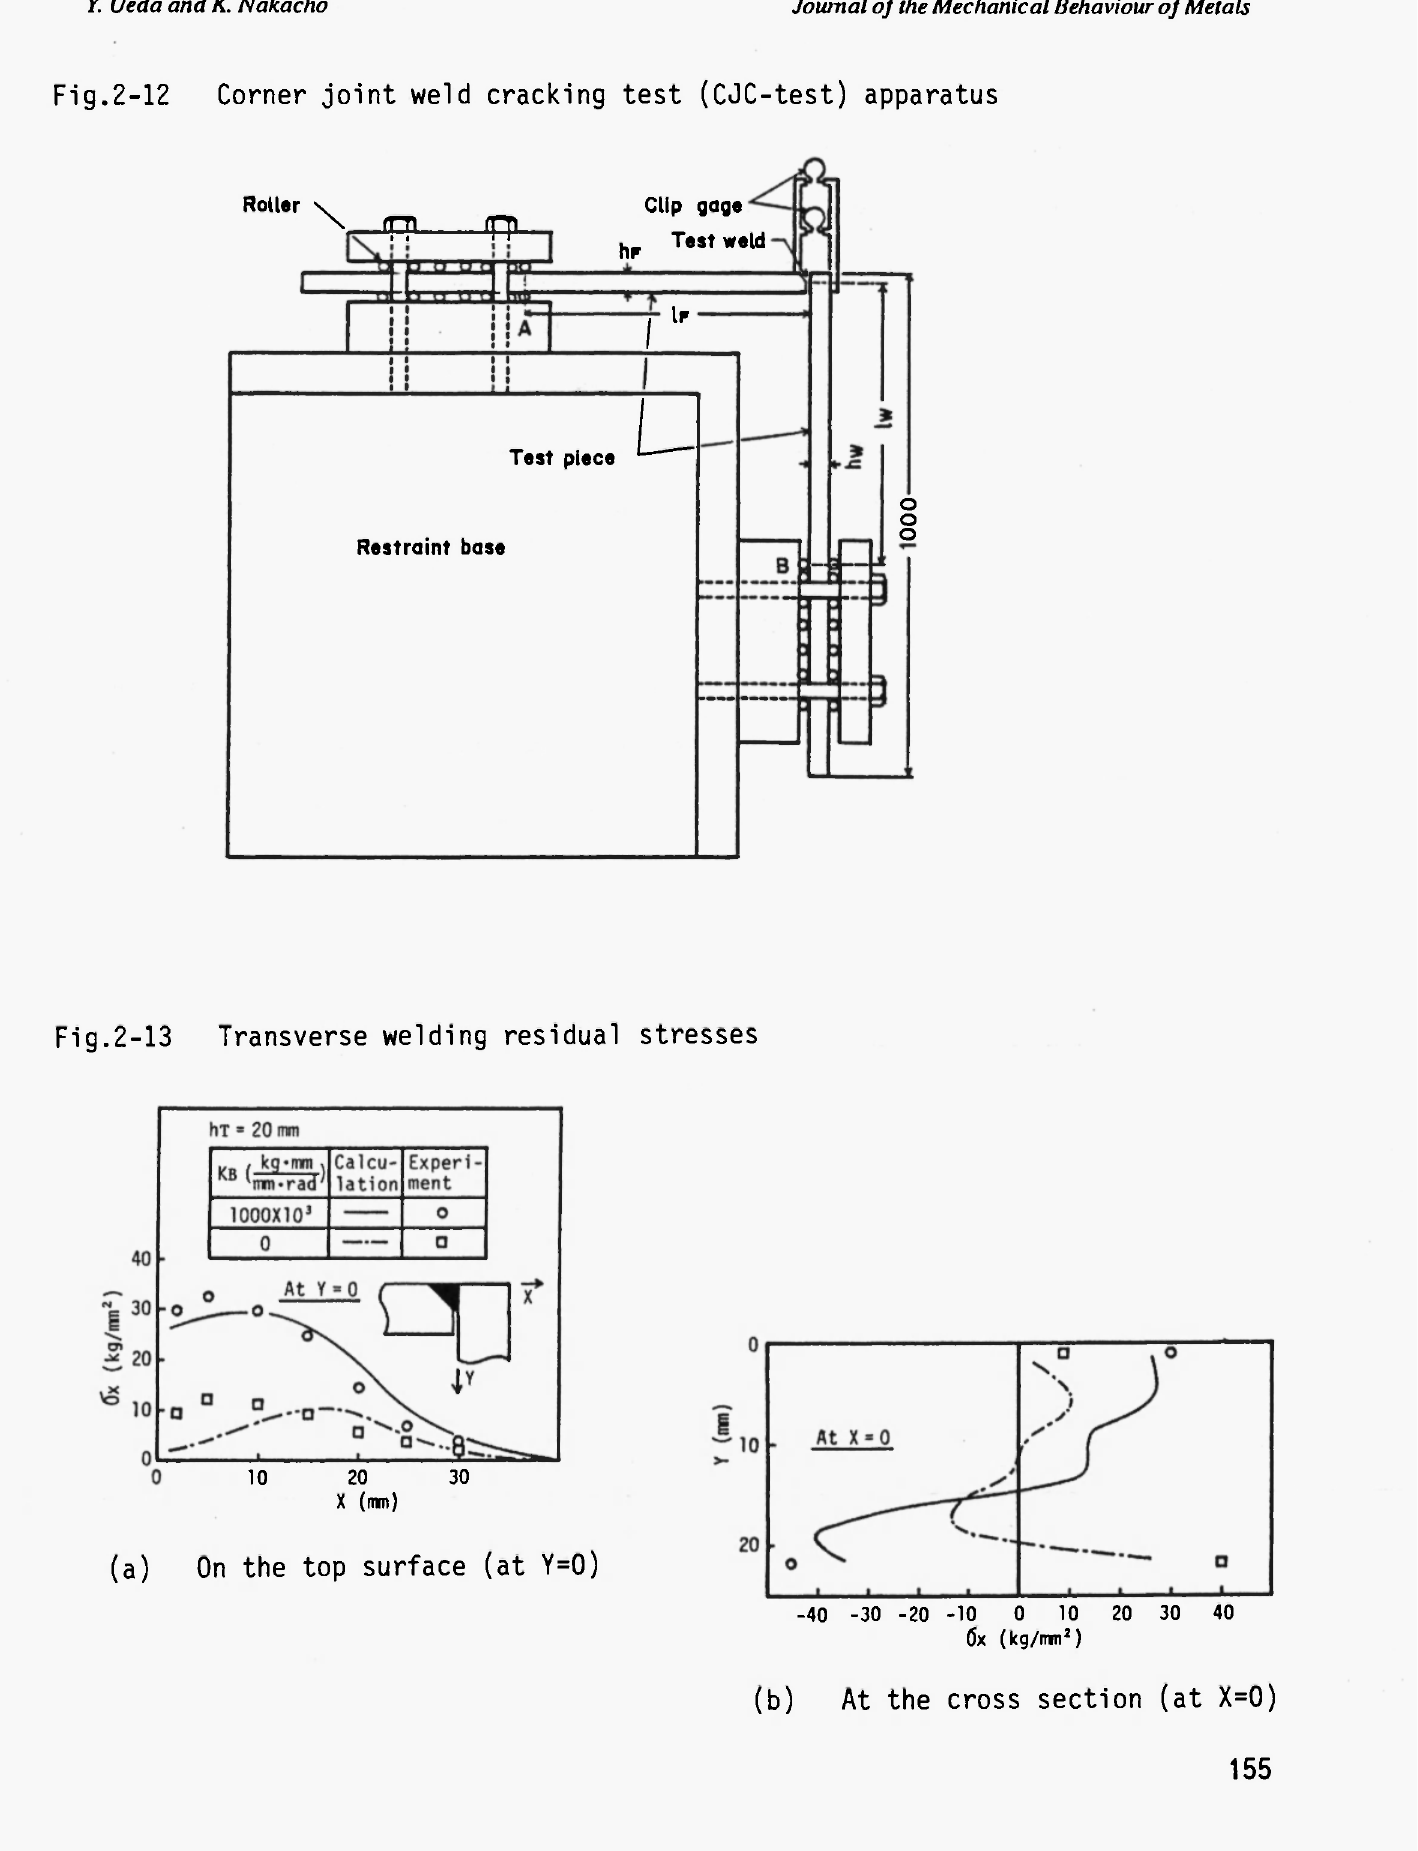
Fig.2-12 Corner joint weld cracking test (CJC-test) apparatus